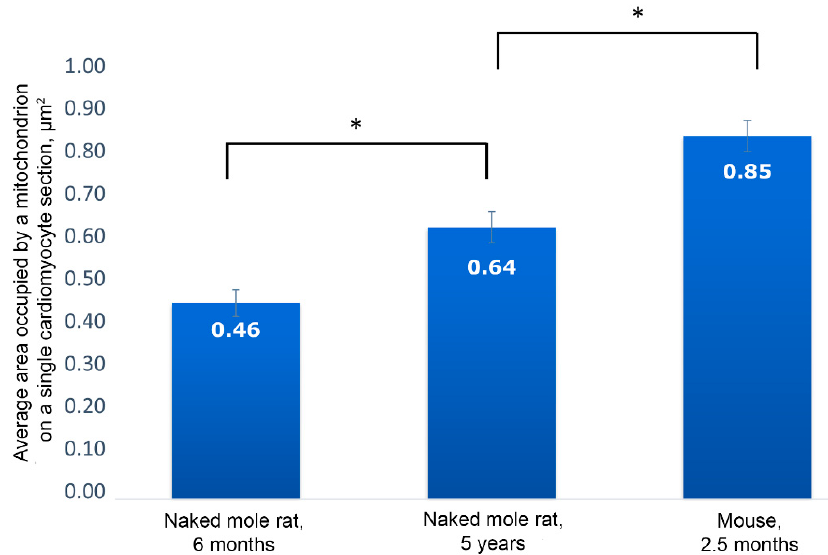
Figure 2. Results of morphometric analysis of cardiomyocyte mitochondrial pool. The average area occupied by a mitochondrion on a single cardiomyocyte section in naked mole rats aged 6 months and 5 years, and in mice aged 2.5 months; * p < 0.05.